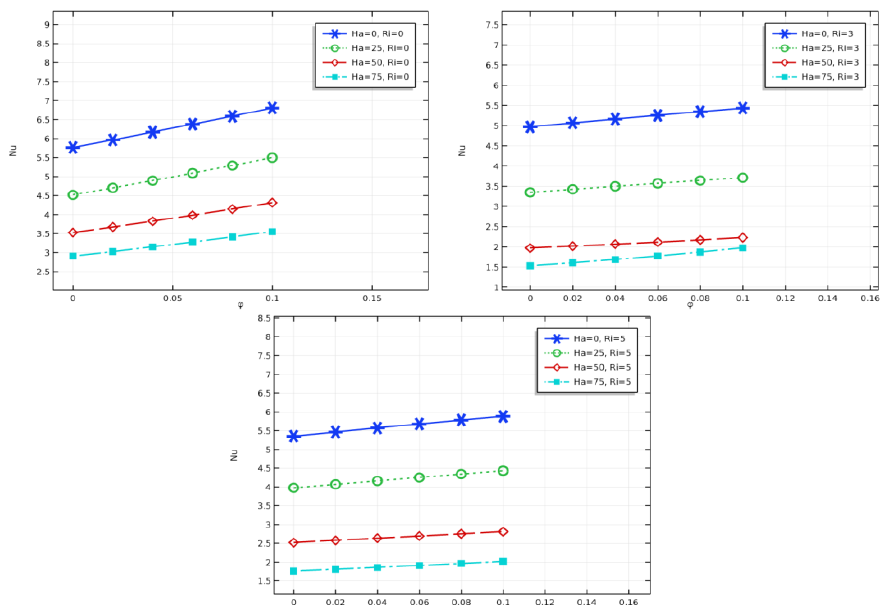
Fig.6. Effect of Ha on average Nusselt Number for different Ha, with J = 0 and Ri = 0,3,5